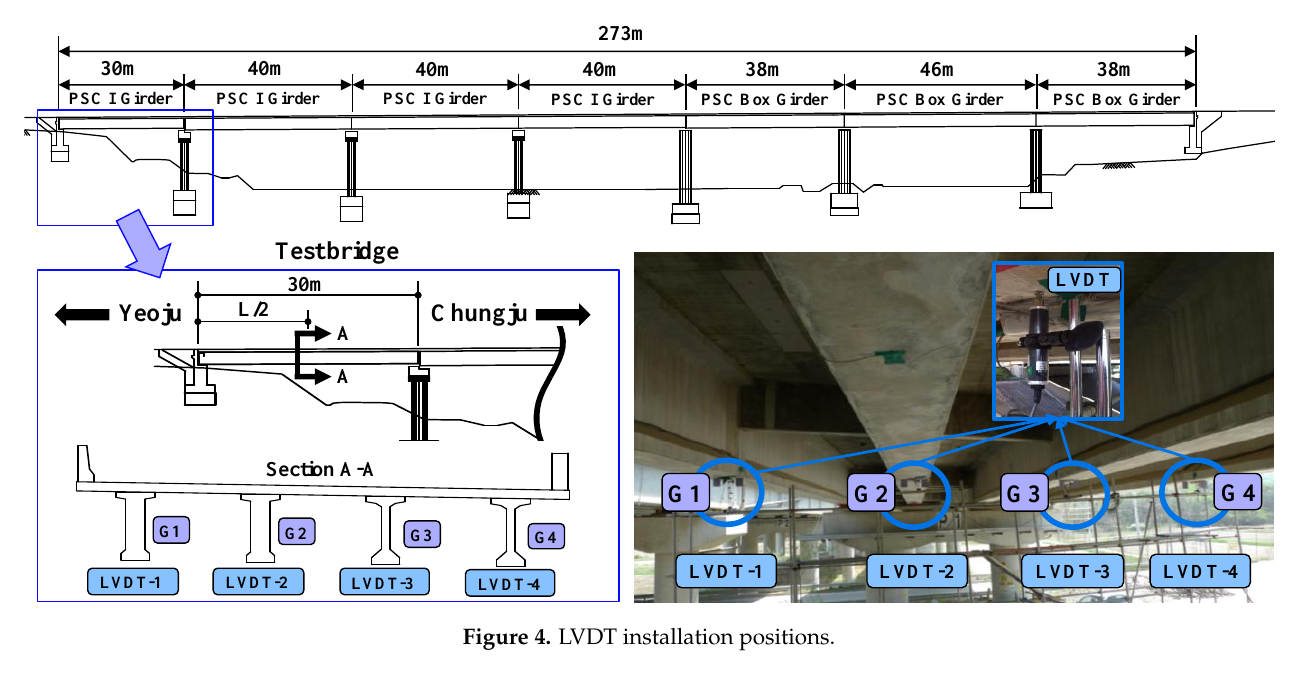
Figure 4. LVDT installation positions.